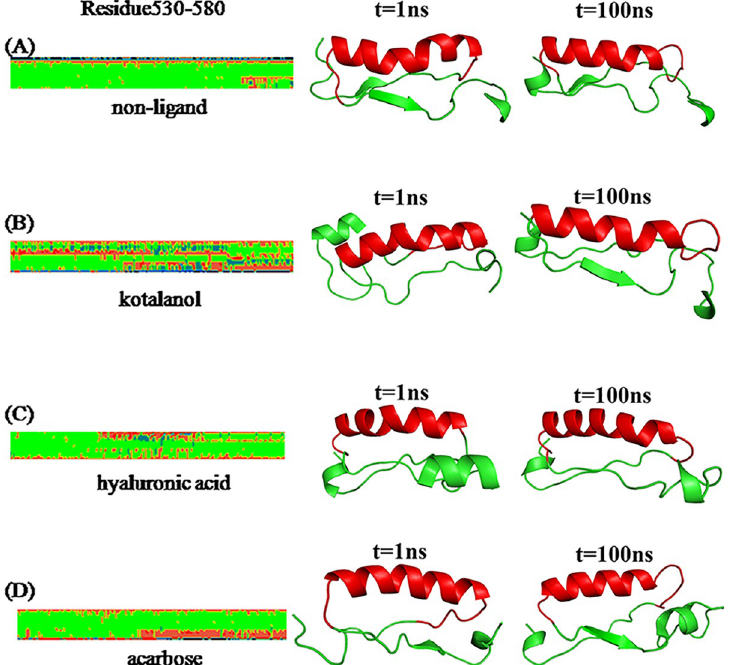
https://doi.org/10.1371/journal.pone.0255351.g005